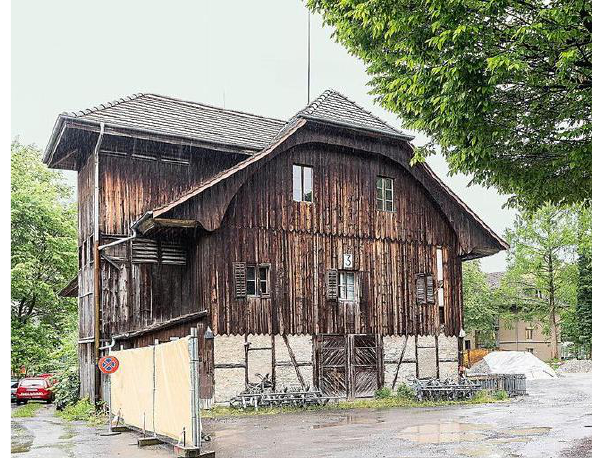
Figure 5 . Building of Salzmagazin museum